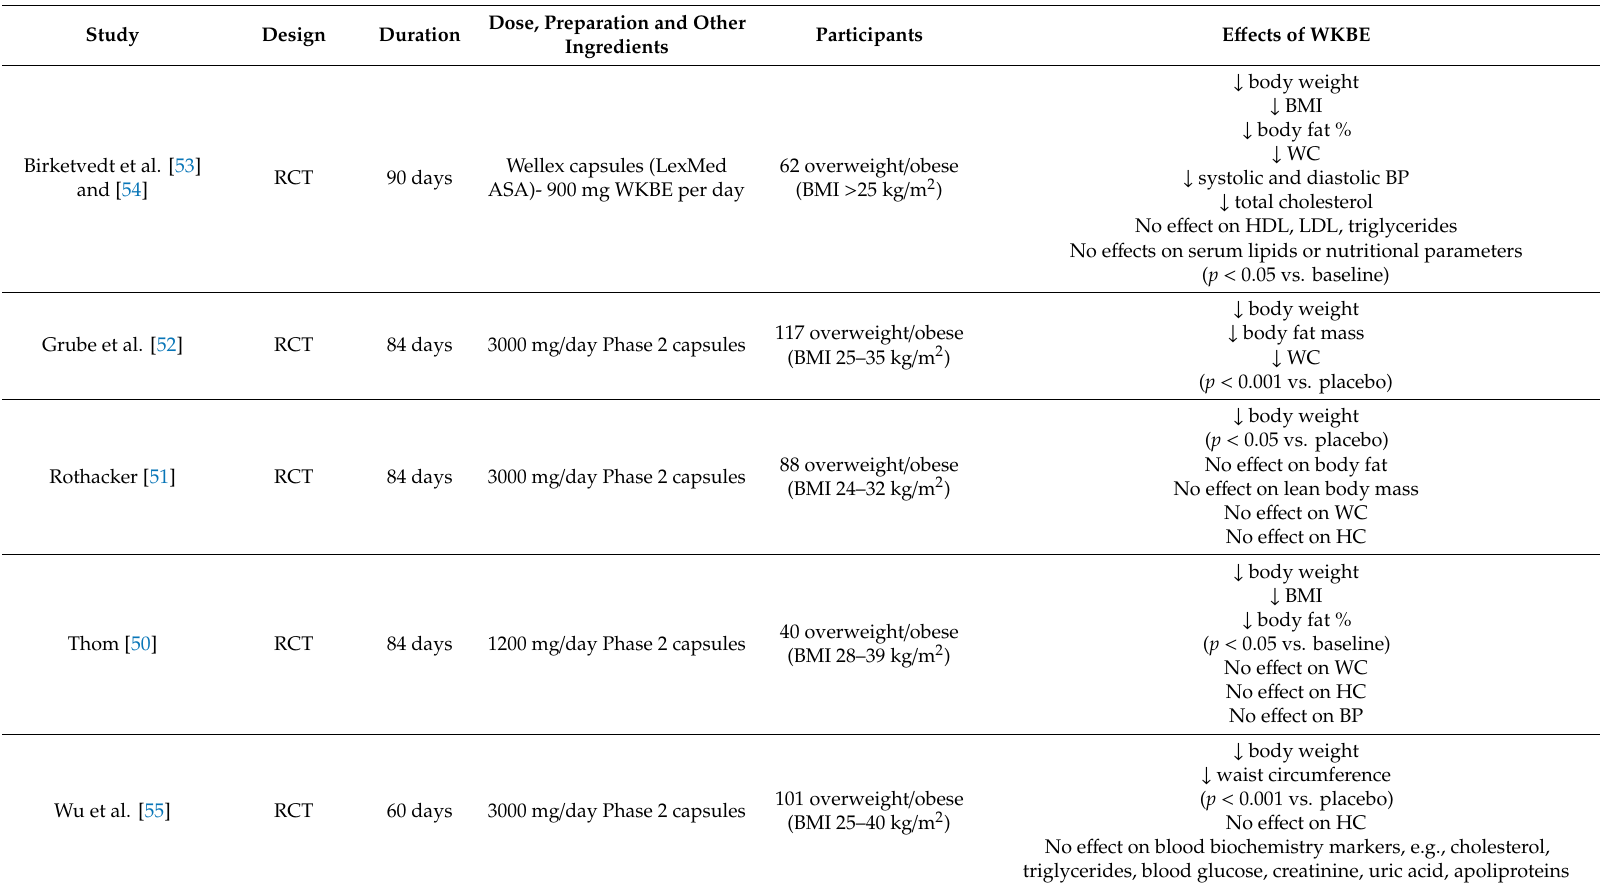
Table 2. Human studies investigating the e ff ects of WKBE on body composition and metabolic risk